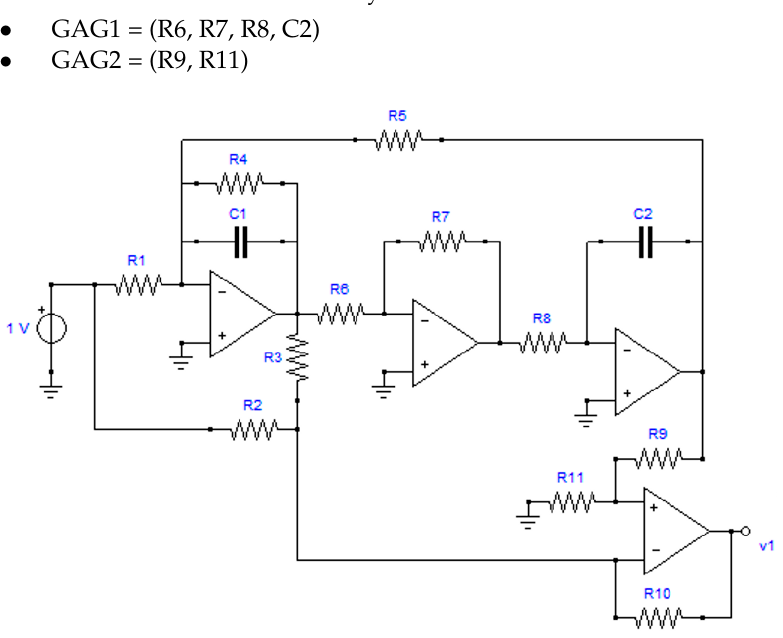
Figure 3. Schematic of the low pass filter.